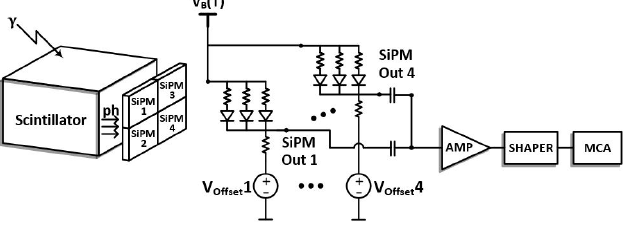
Fig. 4. Simplified block diagram of the proposed detector topology.